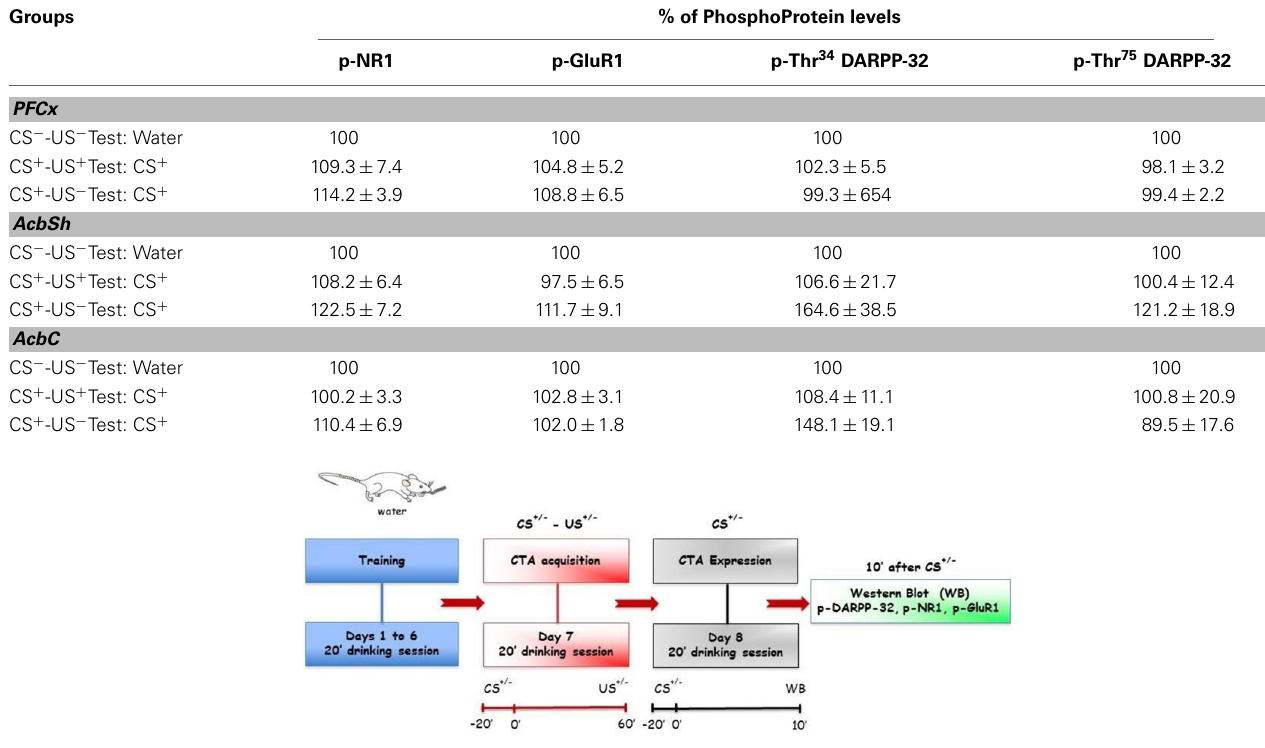
Table 3 | Levels of p-NR1, p-GluR1, p-Thr 34 and p-Thr 75 DARPP-32, in different brain regions after CTA expression.